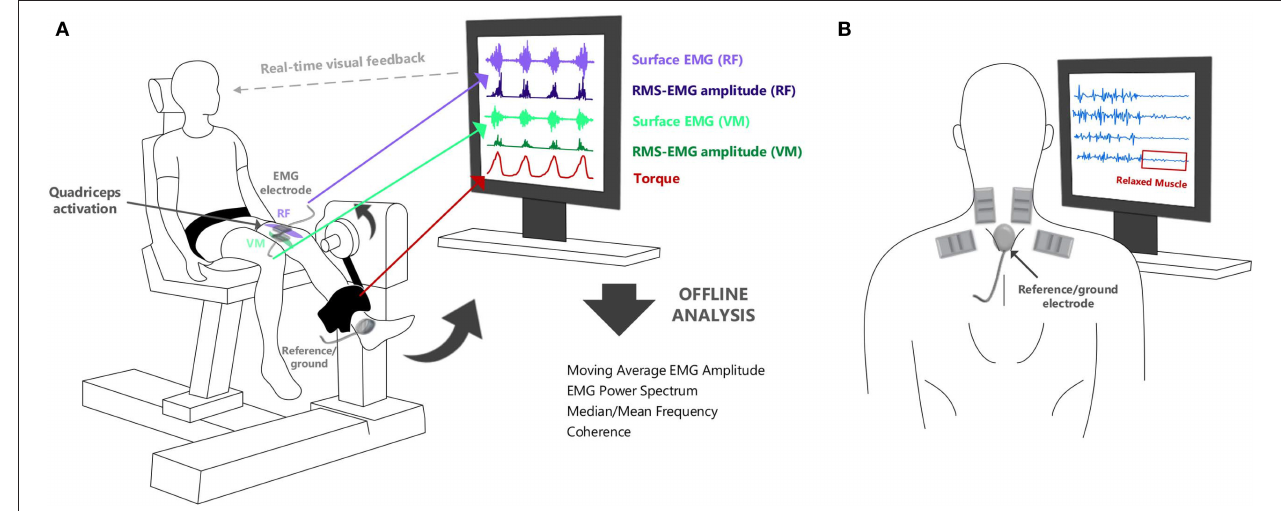
FIGURE 2 | (A) Surface EMG can be used to provide real-time feedback of muscle activation during neuromuscular assessments. It can show the relative timing of activation from selected muscles in different tasks. (B) Visual biofeedback from surface EMG can also aid in muscle training to ensure that rehabilitation tasks are optimally performed (and the correct muscles are “relaxed” or “activated” as required by the